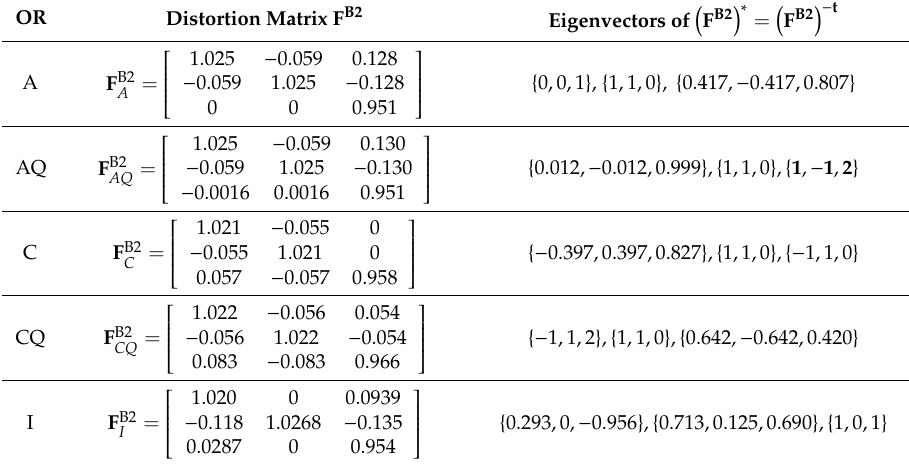
Table 1. Distortion matrices F B2 associated with the di ff erent ORs determined in Section 3. OR (cid:16) (cid:17) ∗ F B2 The eigenvectors of are the planes unrotated by the distortion and are thus candidates to be the martensite habit plane. They are calculated on the B2 basis and given in the second column. The orientation matrices T B2 → B19 (cid:48) can be calculated from the correspondence matrix (1) and the OR fundamental Equation (2).